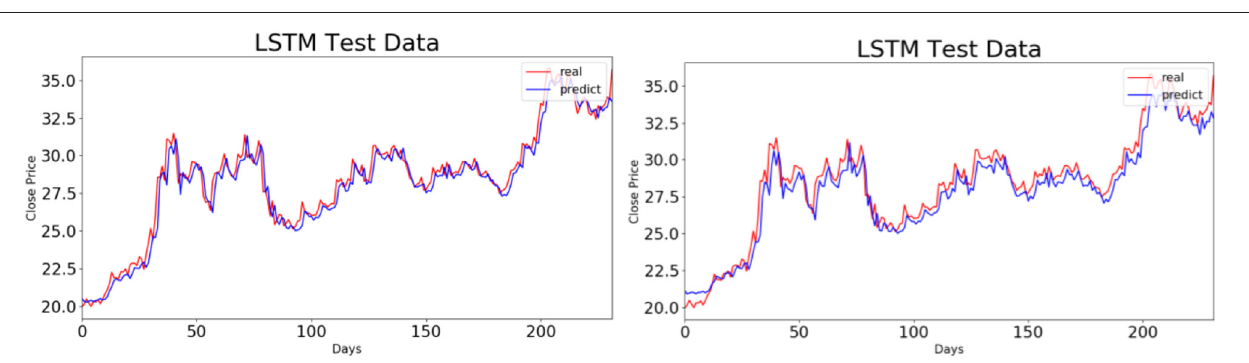
FIGURE 7 | Fitting effect diagrams of long short-term memory neural network model in two test sets. The diagrams on the left and right represent RSY6D5 and RSY6D10, respectively.